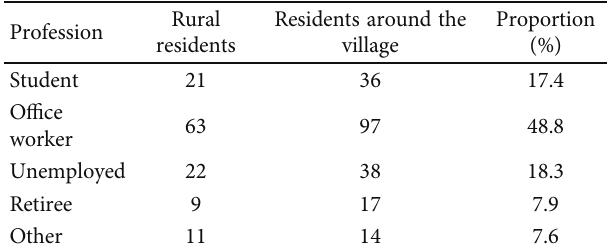
Table 4: Proportion of occupations.